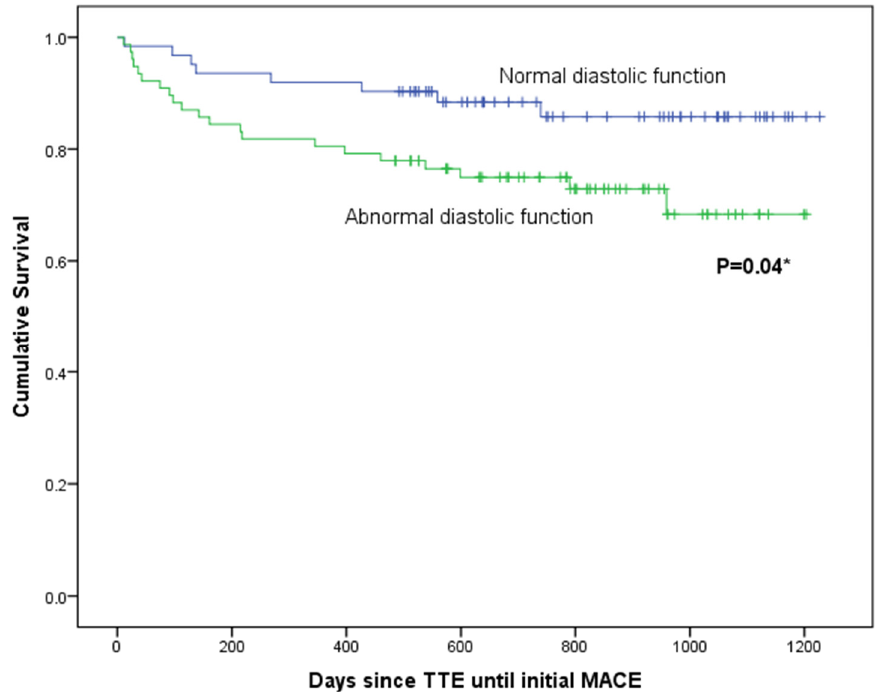
Figure 2. Kaplan–Meier estimates of left ventricular diastolic function (diastolic grade grouped as either normal or abnormal) from time of initial transthoracic echocardiogram to first major adverse cardiac event (MACE). TTE, transthoracic echocardiogram. * Log-rank statistic.